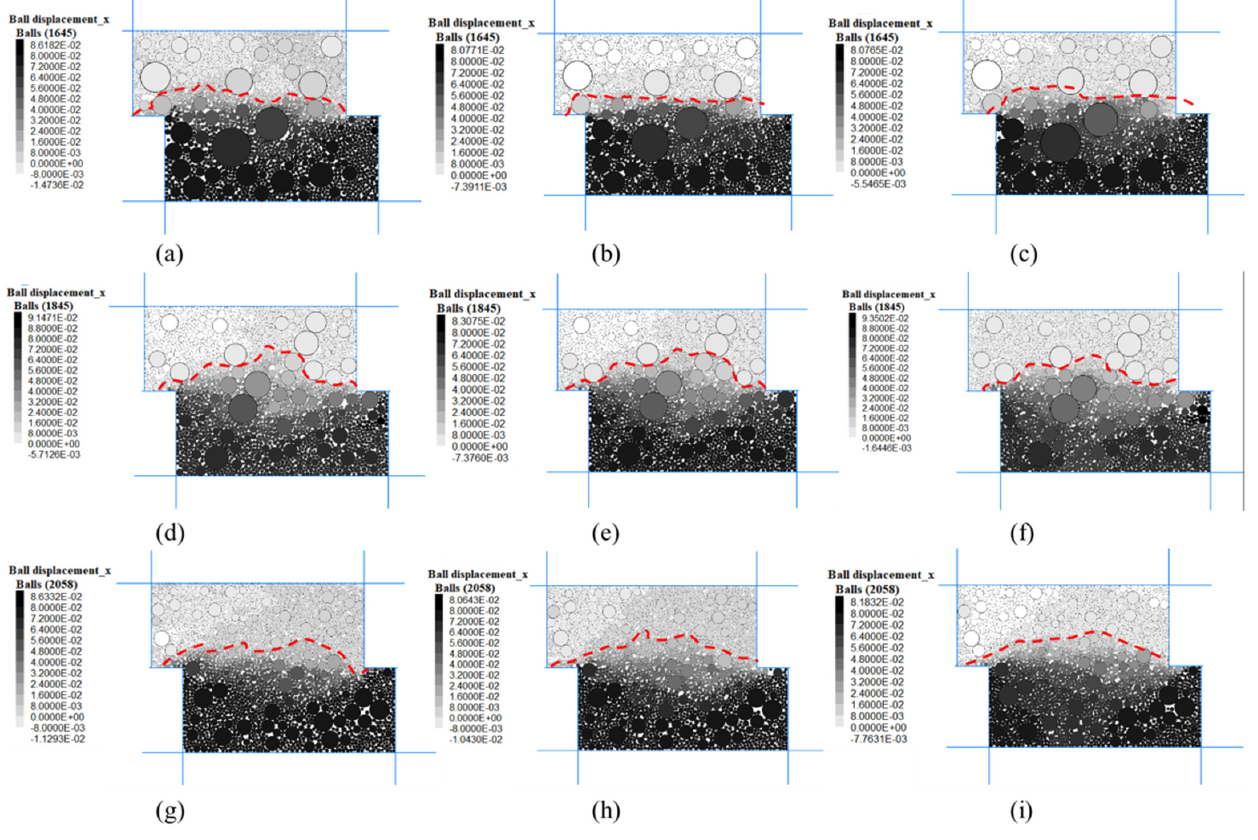
Figure 10. Horizontal displacements of SRM samples at the end of simulations. ( a ) S1-2 × 10 2 kPa, ( b ) S1-4 × 10 2 kPa, ( c ) S1-8 × 10 2 kPa, ( d ) S3-2 × 10 2 kPa, ( e ) S3-4 × 10 2 kPa, ( f ) S3-8 × 10 2 kPa, ( g ) S5-2 × 10 2 kPa, ( h ) S5-4 × 10 2 kPa, and ( i ) S5-8 × 10 2 kPa.